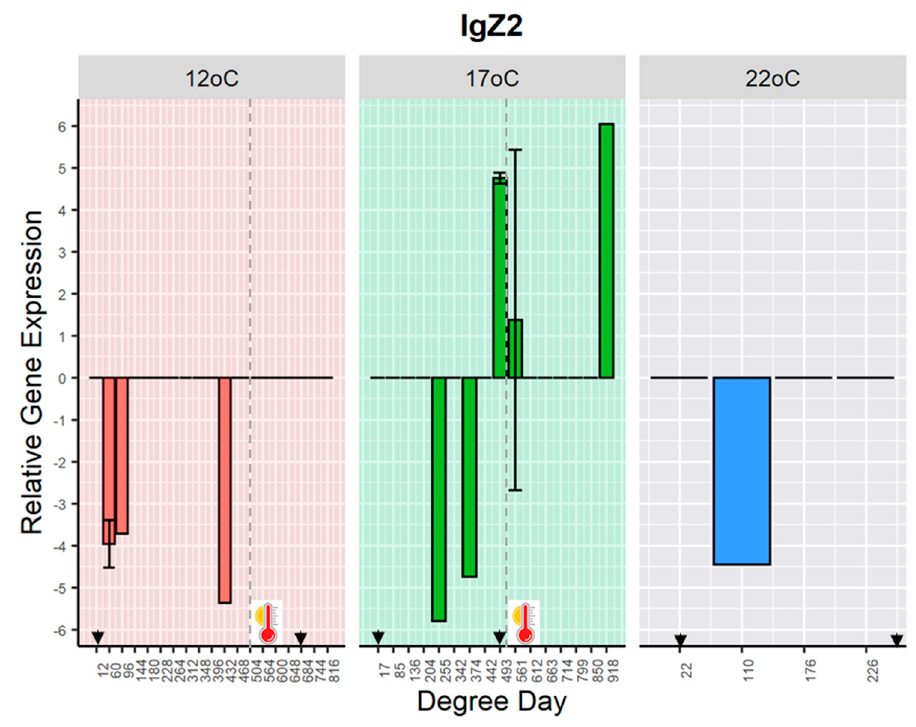
Figure 4. Normalised gene expression of immunoglobulin Z2 heavy chain ( IgZ2 ) over time in common carp skin swabs exposed to koi herpesvirus (KHV). Arrowheads indicate the window of KHV. The vertical black dotted line and thermometer denote a change in the temperate (heat stress) at ~500 DD (42 and 30 days after the challenge for fish at 12 °C and 17 °C respectively).